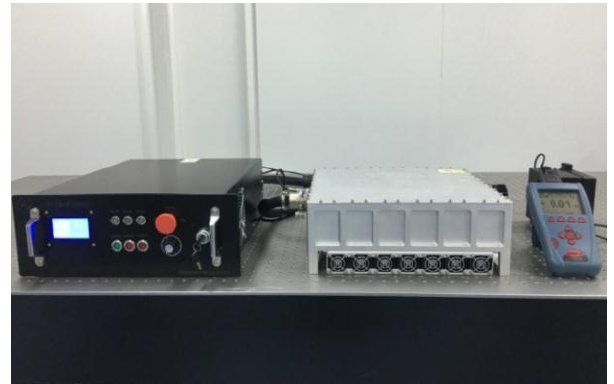
Figure 10. Picture of the mid-infrared OPO laser.